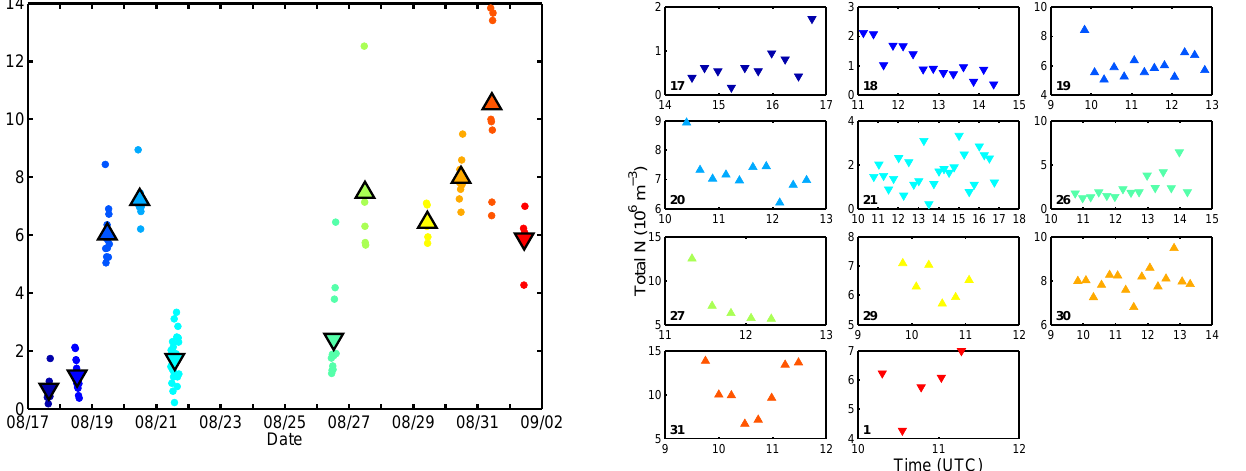
Fig. 10. Time series of total bubble number concentrations for each day. The day of the month is indicated at bottom left of each panel and also by colours matching those in Fig. 9; upward pointing trian- gles indicate flow from an open water surface, downward pointing triangles indicate flow from below an ice-covered surface.